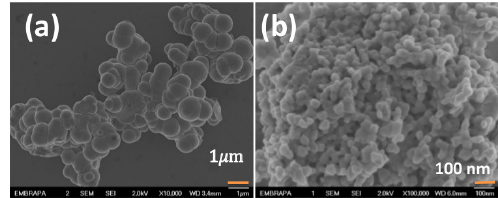
Figure 3. SEM micrographs of Nb 2 O 5 with NH 4 OH in obtaining samples: ( a ) Sol-gel, Nb 2 O 5 —650 ◦ C